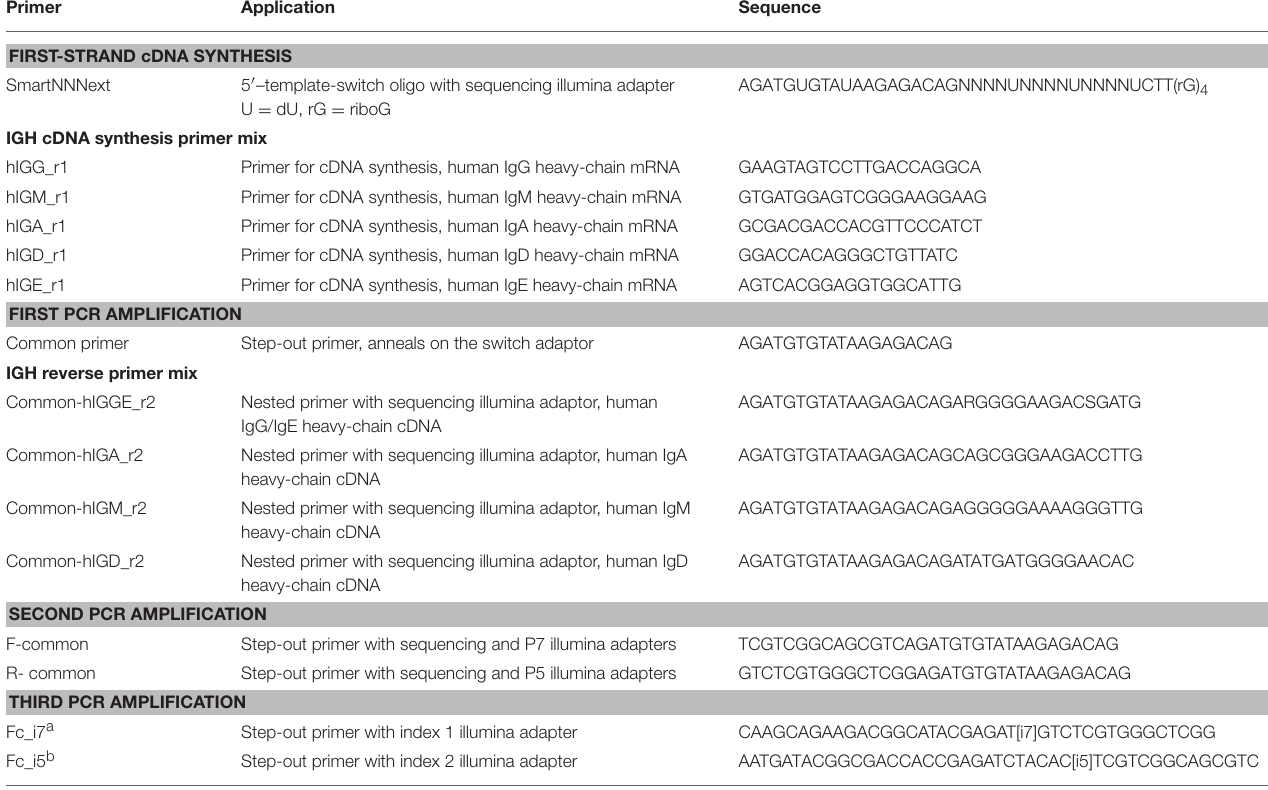
TABLE 2 | Oligonucleotides used. Primer Application